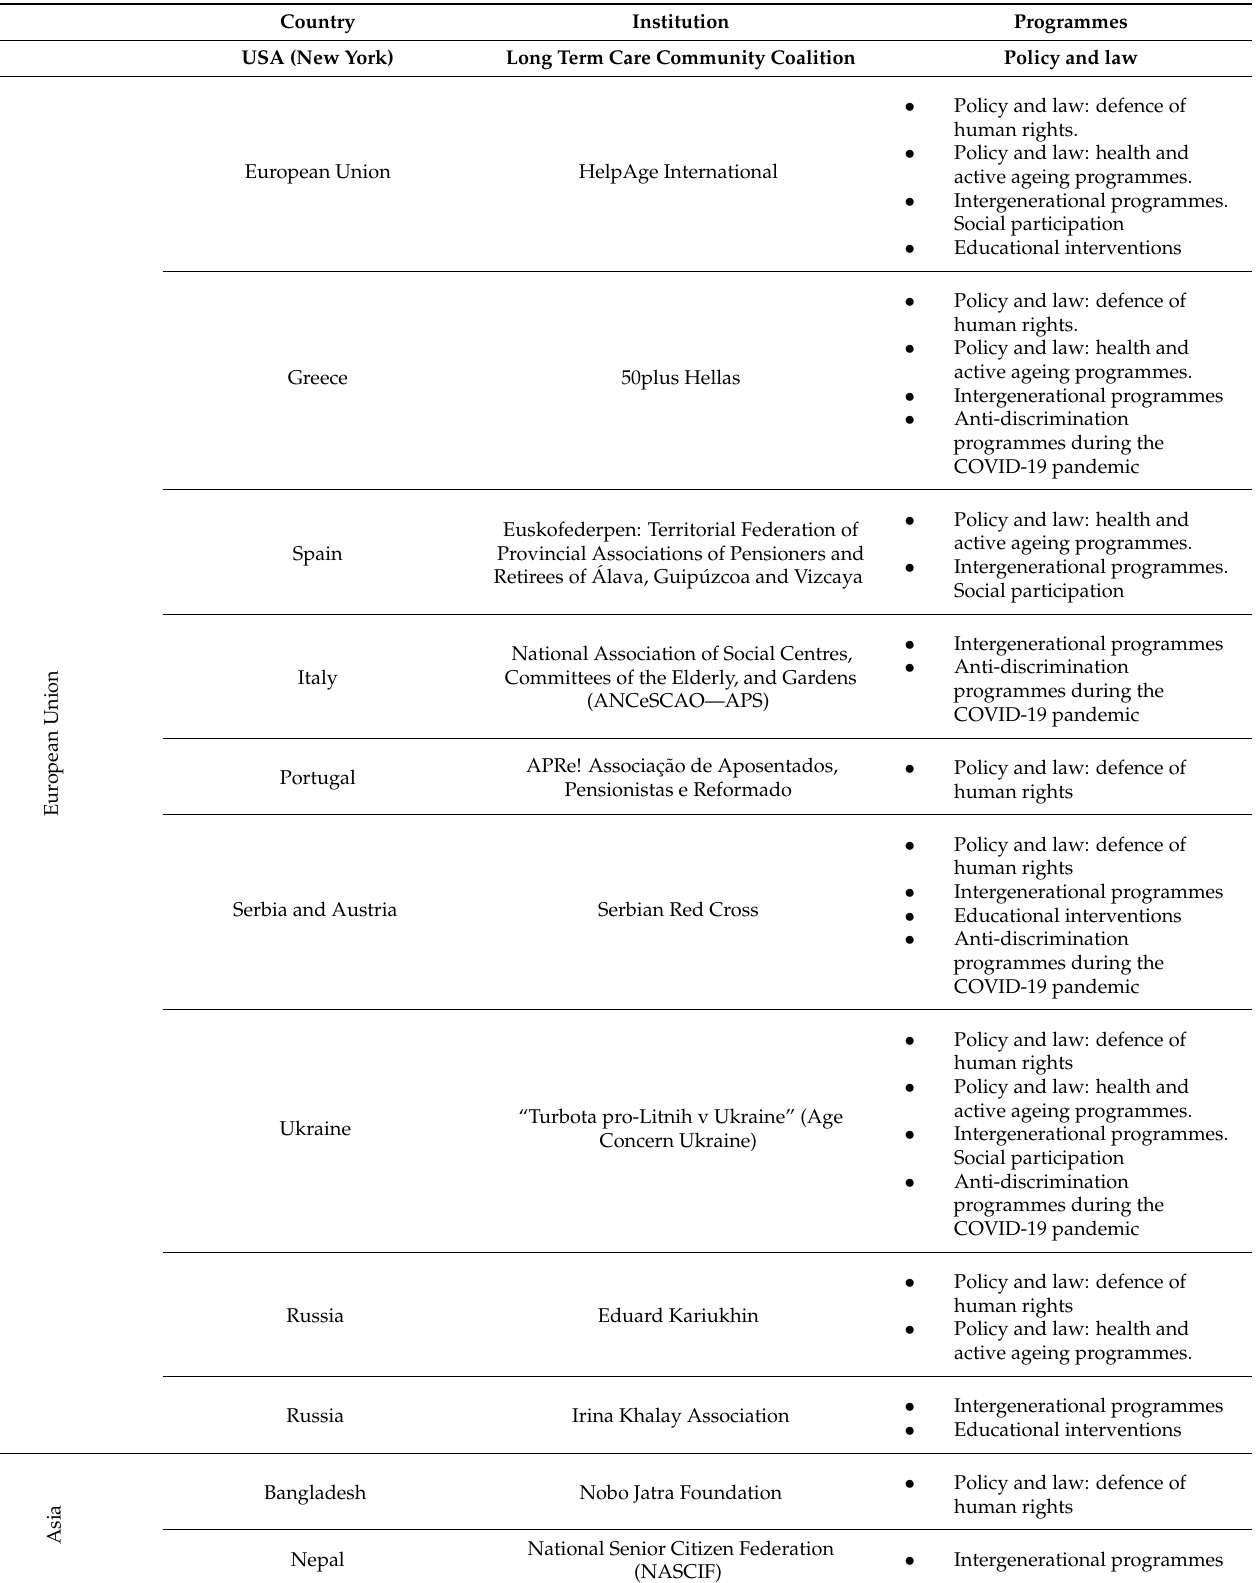
Table 2. Institutions that completed the online questionnaire and their